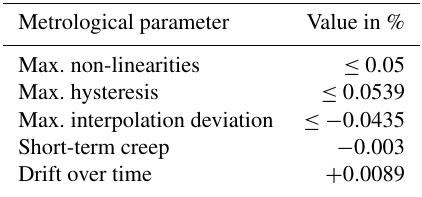
Table 1. Metrological parameters of the 5MNm TTS. Metrological